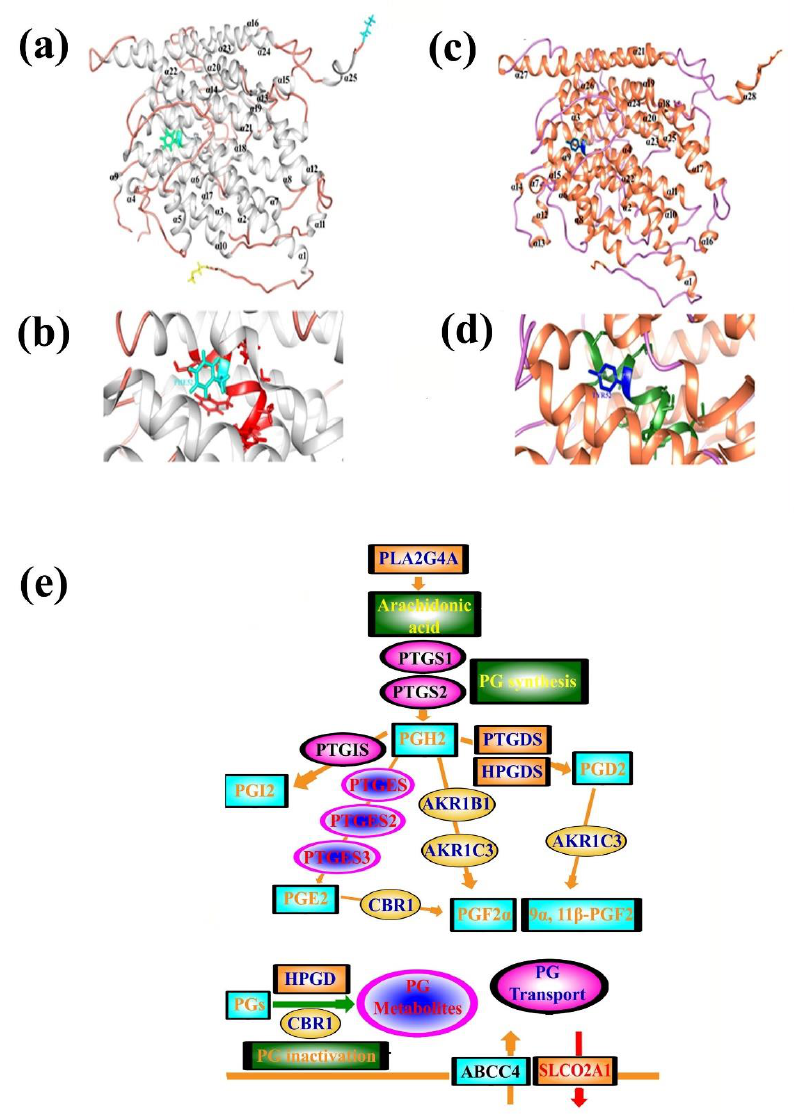
Figure 3. Protein structural and close-up view of SLCO2A1 WT and SLCO2A1 MUT . ( a ) Structural representation of SLCO2A1 WT and ( c ) structural representation of SLCO2A1 PHE52TYR ( b ) Zoomed representation of SLCO2A1 WT and ( d ) zoomed representation of SLCO2A1 PHE52TYR . PHE52 is depicted in cyan, while the TYR52 is presented in dark blue color. ( e ) Schematic representation of the pathway and key role of the SLCO2A1 and other key players in the transmembrane transporter. Different genes involved in the signaling and PGE2 biosynthesis pathway have been presented.